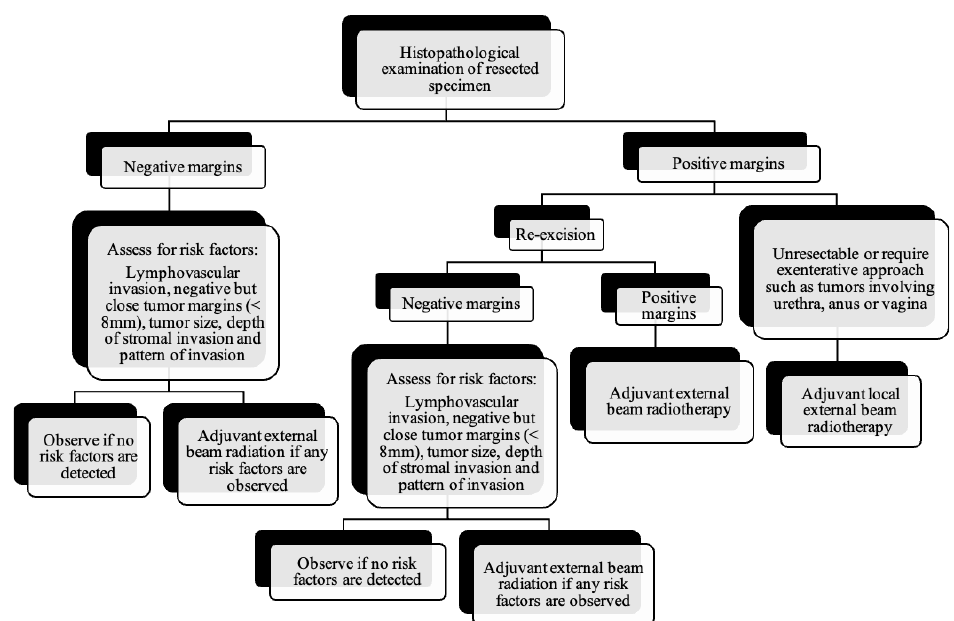
Figure 9. Post-surgical surveillance of vulvar cancer.